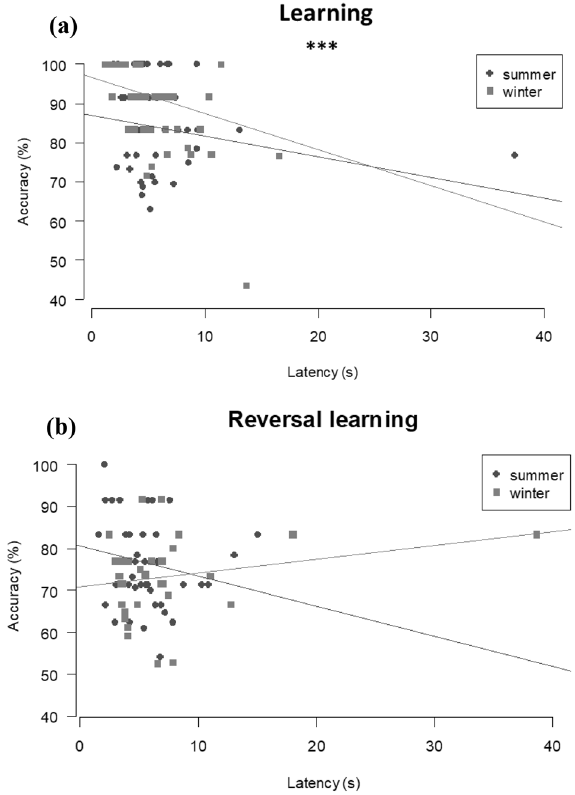
Figure 3. Influence of the season on speed accuracy trade-off measured by the relationship between mean latency (seconds) calculated from all trials during ( a ) the learning (N = 87) task and ( b ) the reversal learning tasks (N = 78); and accuracy measured as the number of correct responses divided by the total number of responses (Spearman rank correlation, ***P <